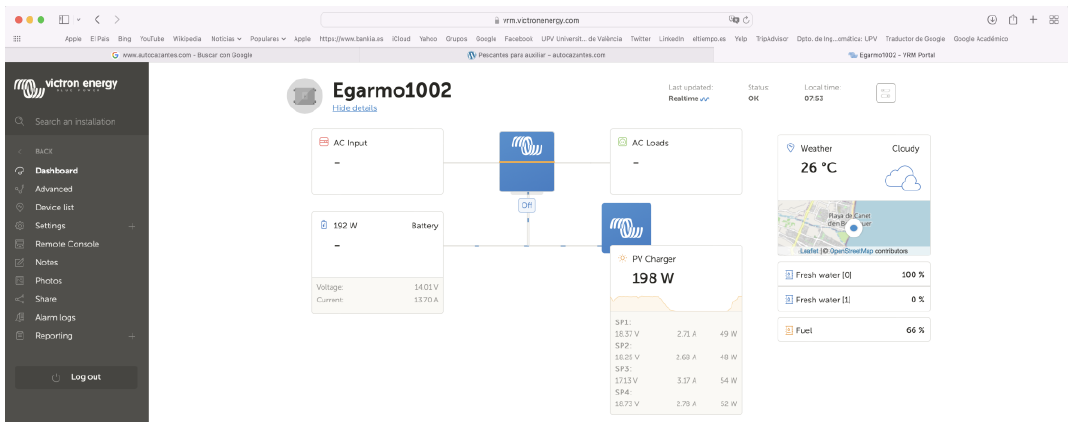
Figure 10. Victron connect